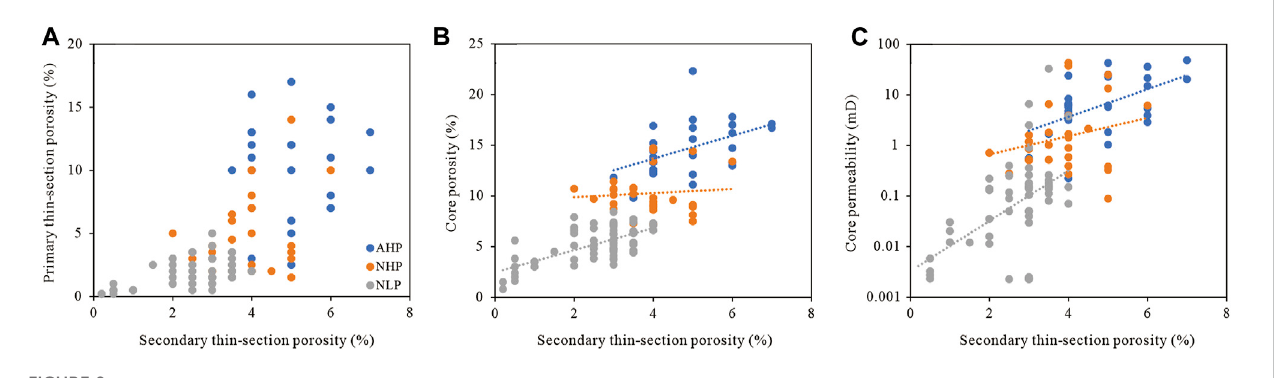
FIGURE 9 Cross-plotting of the secondary thin-section porosity versus the primary thin-section porosity (A) , core porosity (B) , and core permeability (C)